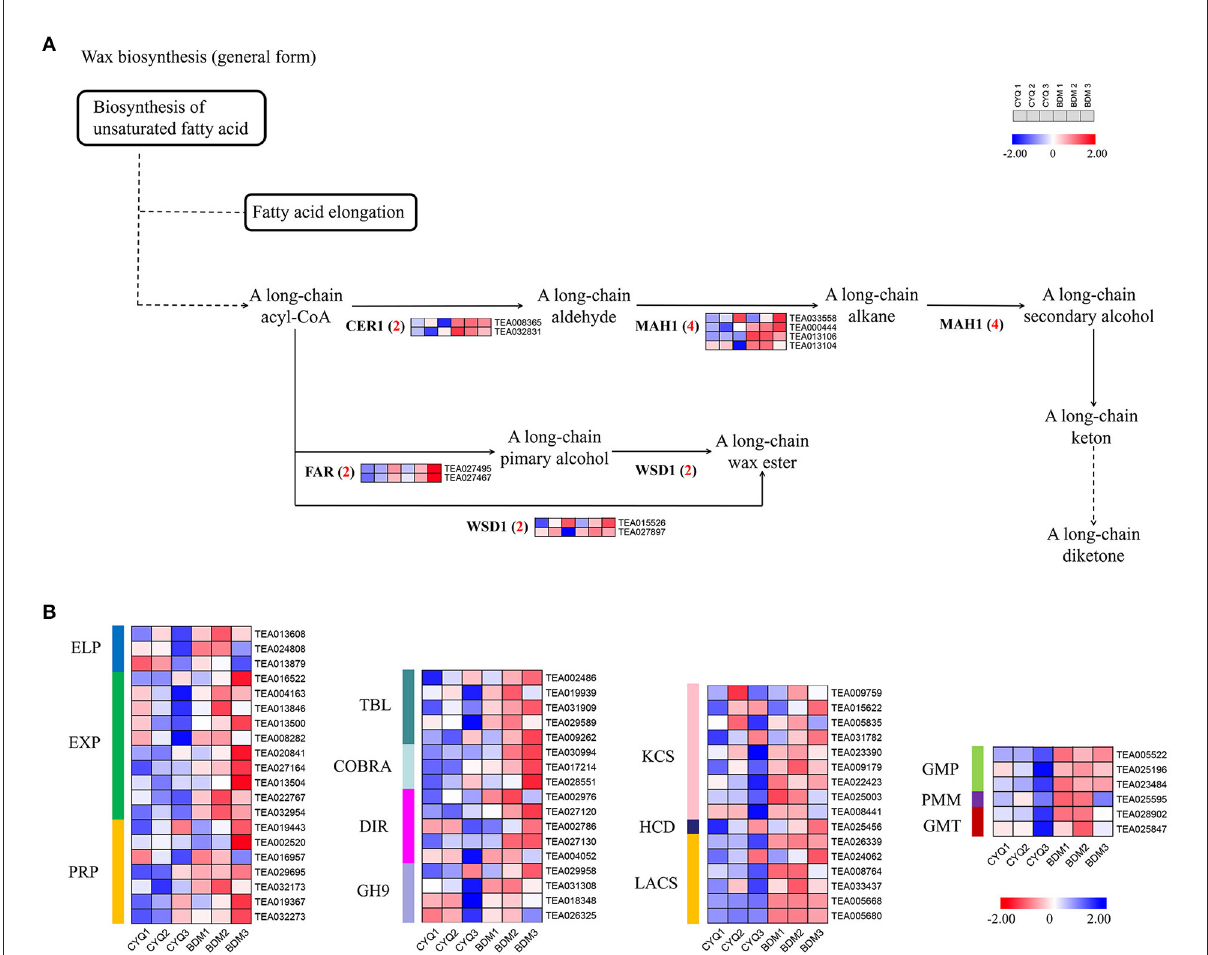
FIGURE8 The expression pattern of cuticular wax biosynthesis pathway. (A) DEGs involved in cuticular wax biosynthesis pathway. Numbers in parentheses following each gene name indicated the number of corresponding DEGs. The expression levels of DEGs were normalized by log 2 (FPKM). (B) Heatmap of other cell wall material-related genes. The expression levels of DEGs were normalized by log 2